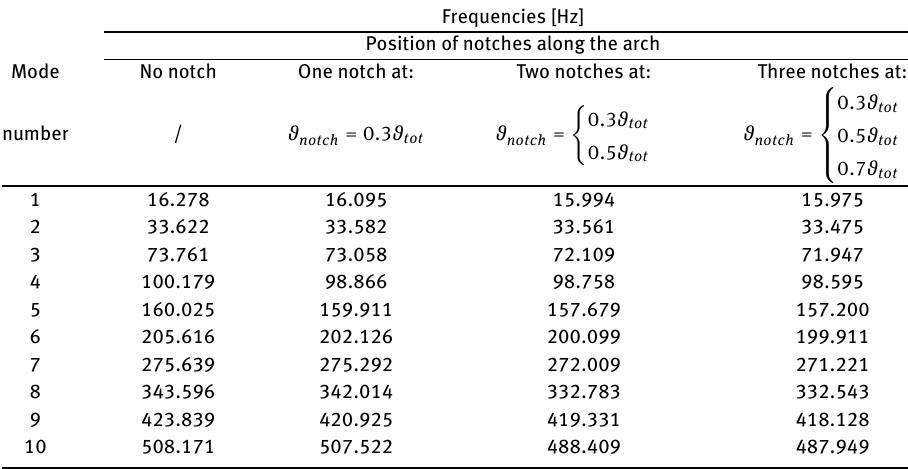
Figure 6: Effect of the variation of the single rigidity: K a , K t or K r on the first 12 vibration modes of the damaged parabolic arch. The notch is located in the key section. Table 7: First ten natural frequencies of three-stepped and multi-damaged Clamped-Hinged parabolic arches, only taking the rotational stiffness into account ( K r = 219